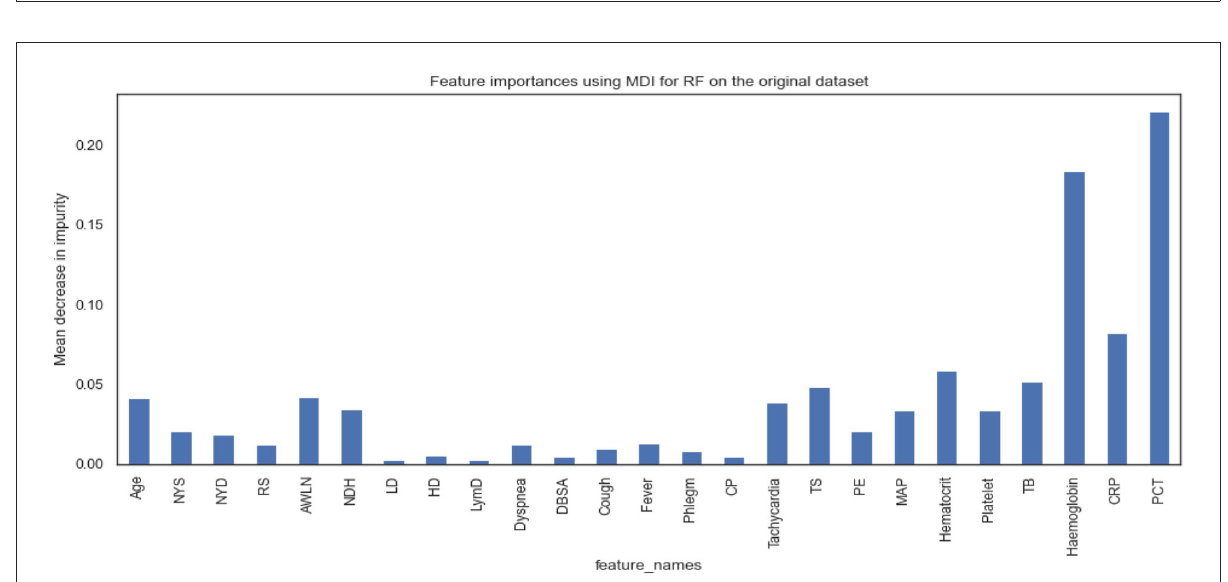
FIGURE6 Feature importance according to the RF model on the original